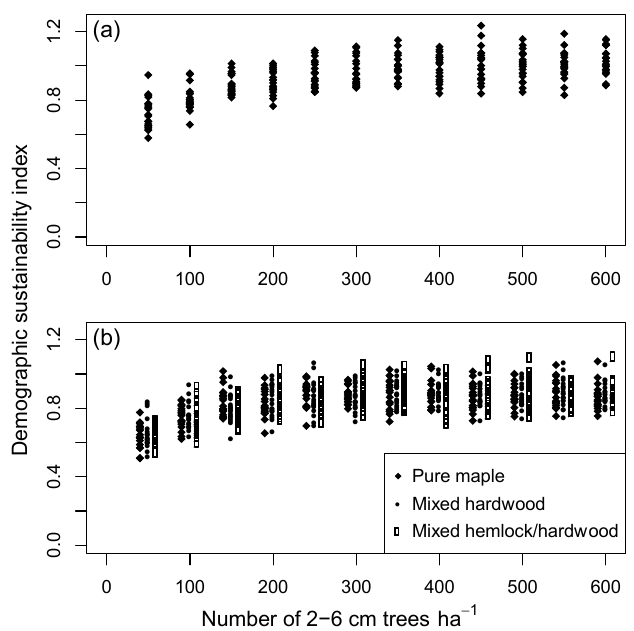
Figure 7. Pooled-species demographic sustainability index values from 1000-year simulation experiments with varying densities of small saplings (Group 2 simulations). ( a ) Pure maple stand where saplings were added if necessary to maintain the specified sapling density (Group 2a simulations); ( b ) Stands where the specified sapling density was used as a limit (i.e., additional trees were not added if mortality reduced the population below the specified density; Group 2b–d simulations).